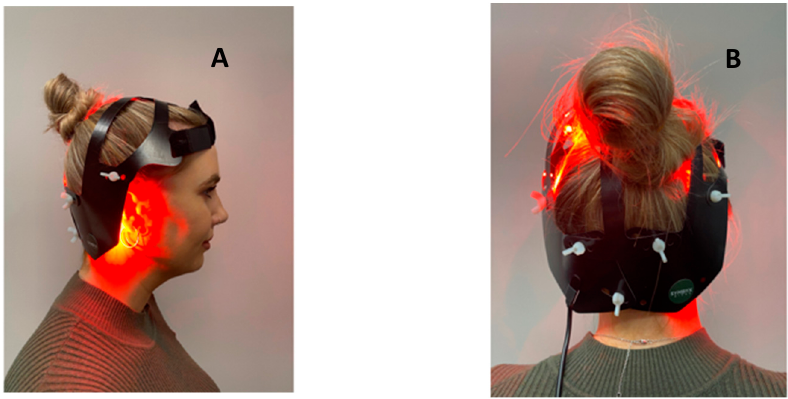
Figure 2. Images of the SYMBYX Neuro tPBM helmet. ( A ) Lateral view; ( B ) Posterior view.